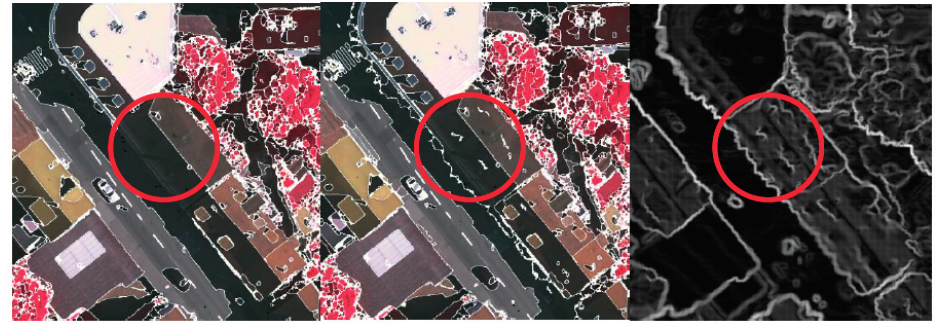
Figure 3. An example of synergic mean-shift (MS) segmentation. ( Left ) Classic mean-shift segmentation; ( middle ) height-assisted synergic MS segmentation; ( right ) boundary probability map derived from the DSM. The interpretation of the red circle is in the